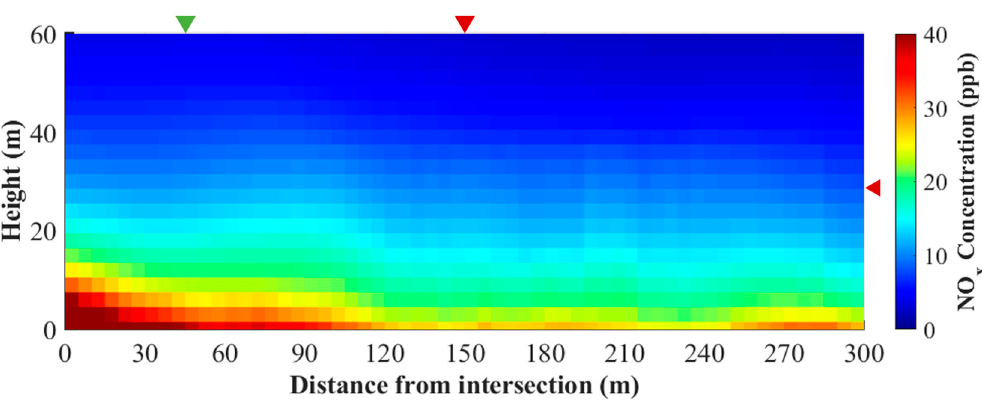
Figure 9. Composited cross-section of simulated NO x concentration in terms of distances from the intersection at a model grid interval regardless of direction. Green and red markers denote the drone and stationary measurement locations, respectively.